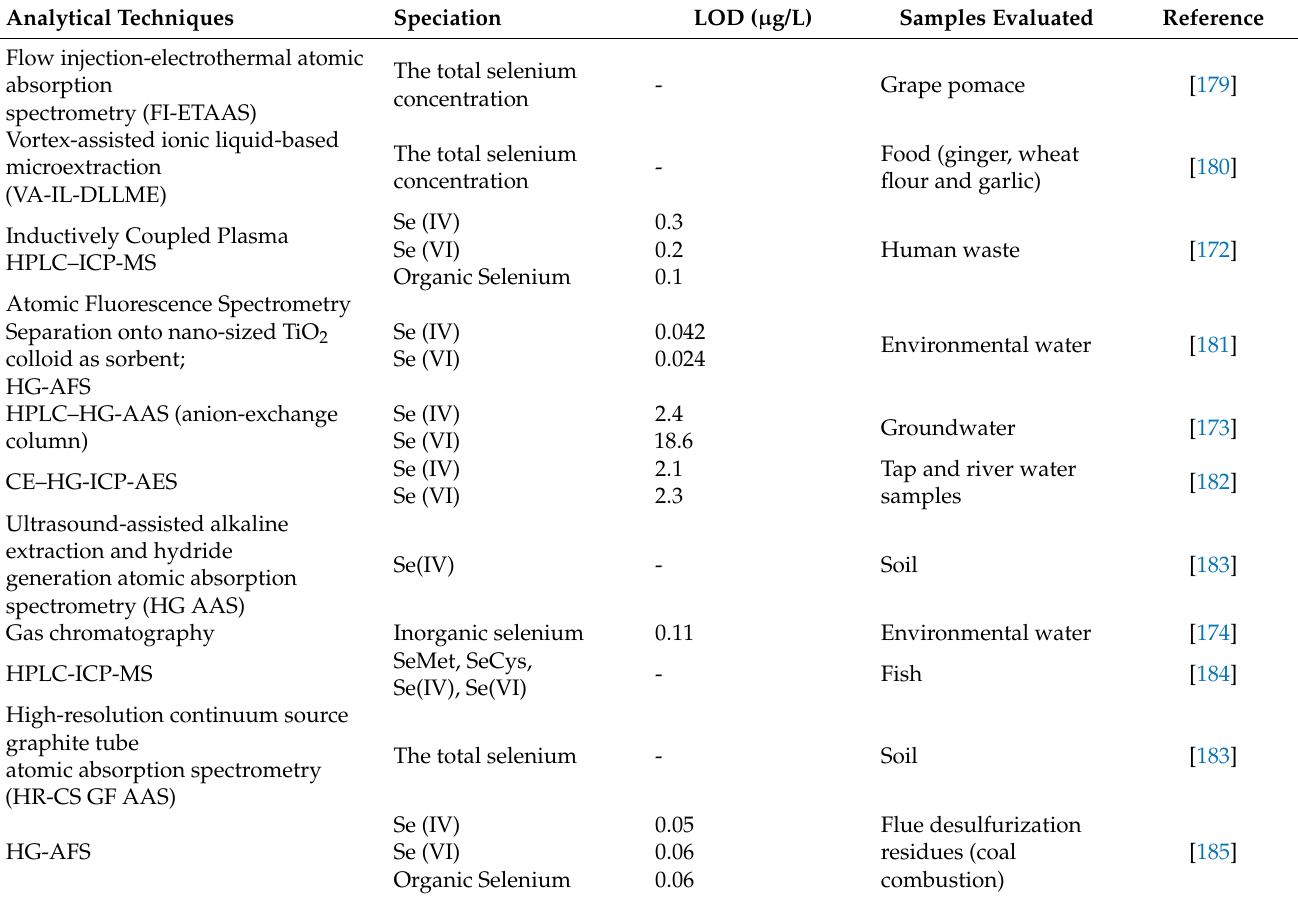
Table 2. Examples of analytical techniques for selenium detection and